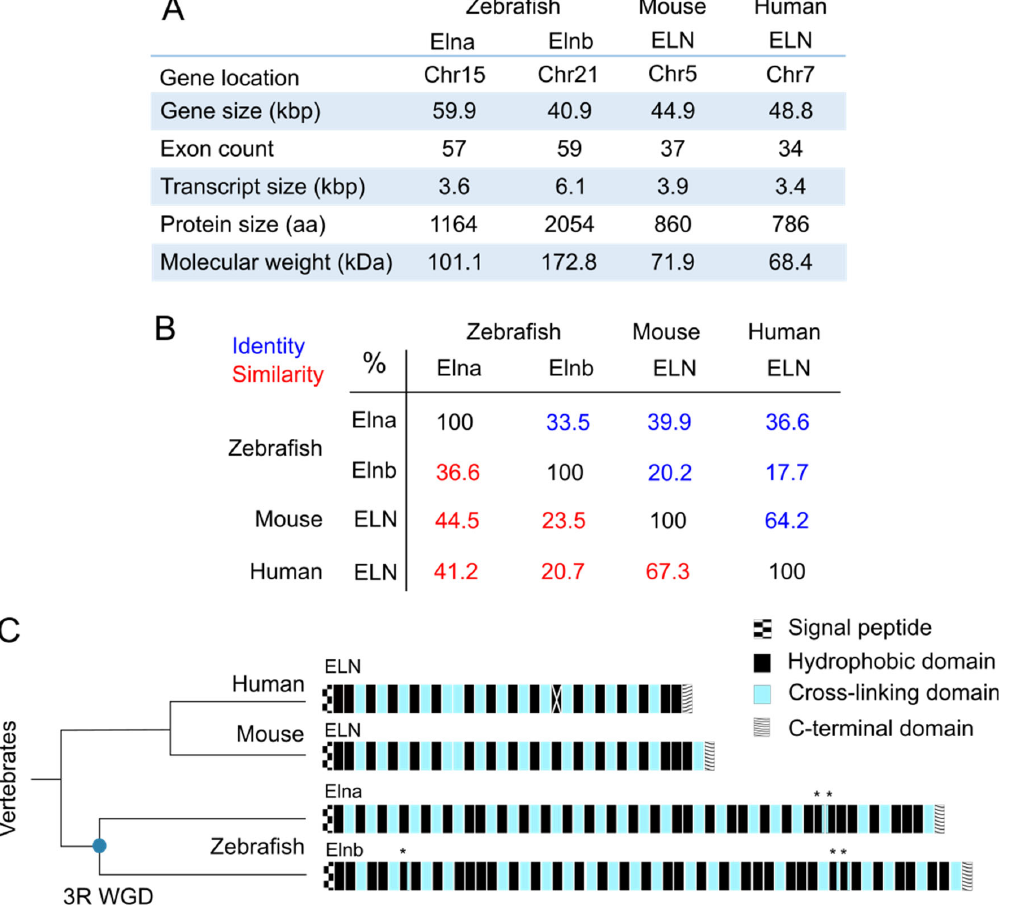
Figure 1. Comparison of tropoelastin sequences from zebrafish ( Danio rerio ), mouse ( Mus musculus ) and human ( Homo sapiens ). ( A ) Main characteristics of the four tropoelastins previously mentioned; kbp = kilobase pairs; kDa = kilodalton; aa = amino acid; Chr = chromosome; Data from GenBank, RefSeq NCBI and UniProt; ( B ) matrix table of the identity and similarity percentages resulting from the alignment of tropoelastin protein sequences from zebrafish (Elna TR|Q0Q5Z1|Q0Q5Z1_DANRE, Elnb TR|Q0Q5Z0|Q0Q5Z0_DANRE), mouse (ELN SP|P54320|ELN_MOUSE) and human (ELN SP|P15502|ELN_HUMAN) from UniProt, with the EMBOSS-Needle tool from EMBL-EBI; ( C ) representation of tropoelastin domains in human (ELN), mouse (ELN), and zebrafish (Elna and Elnb). Zebrafish have two tropoelastins due to a duplication event, the 3rd round whole genome duplication (3R WGD), which is symbolized by a blue round on the schematic phylogenetic tree chart. Each rectangle represents a domain, the white cross on human ELN exon 22 represents the fact that it is spliced in all transcripts; * indicates domains with both hydrophobic and cross-linking characteristics; exons 13 and 14 in human ELN are not always attributed this way